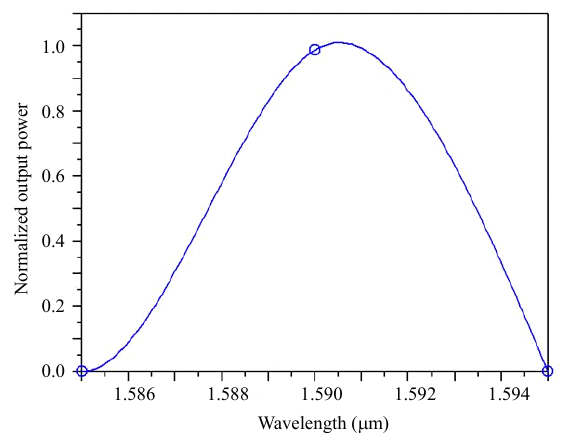
Fig. 6 Normalized output transmission spectra for normal range of blood components in